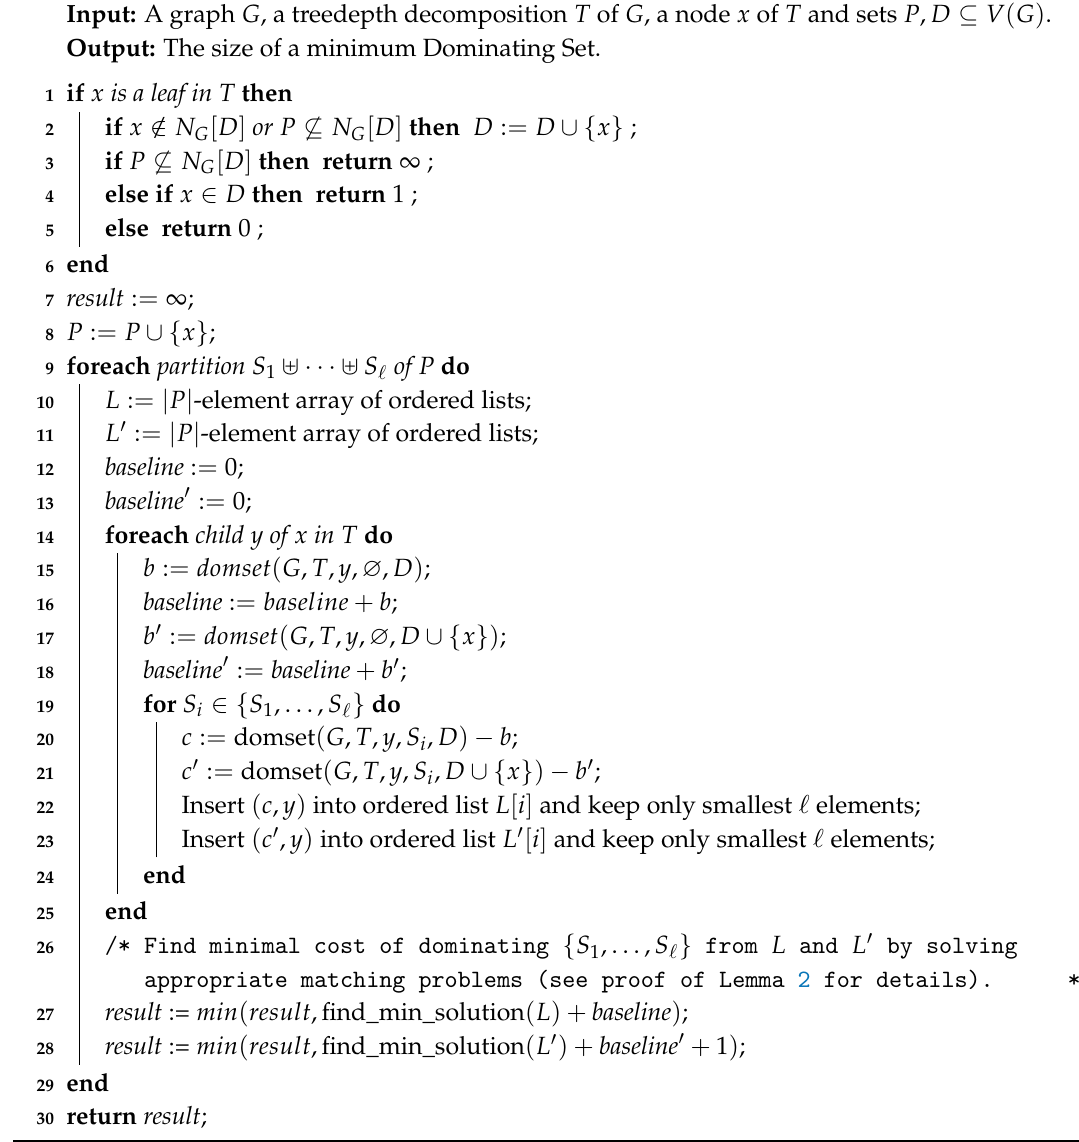
Algorithm 1: Computing dominating sets with very little